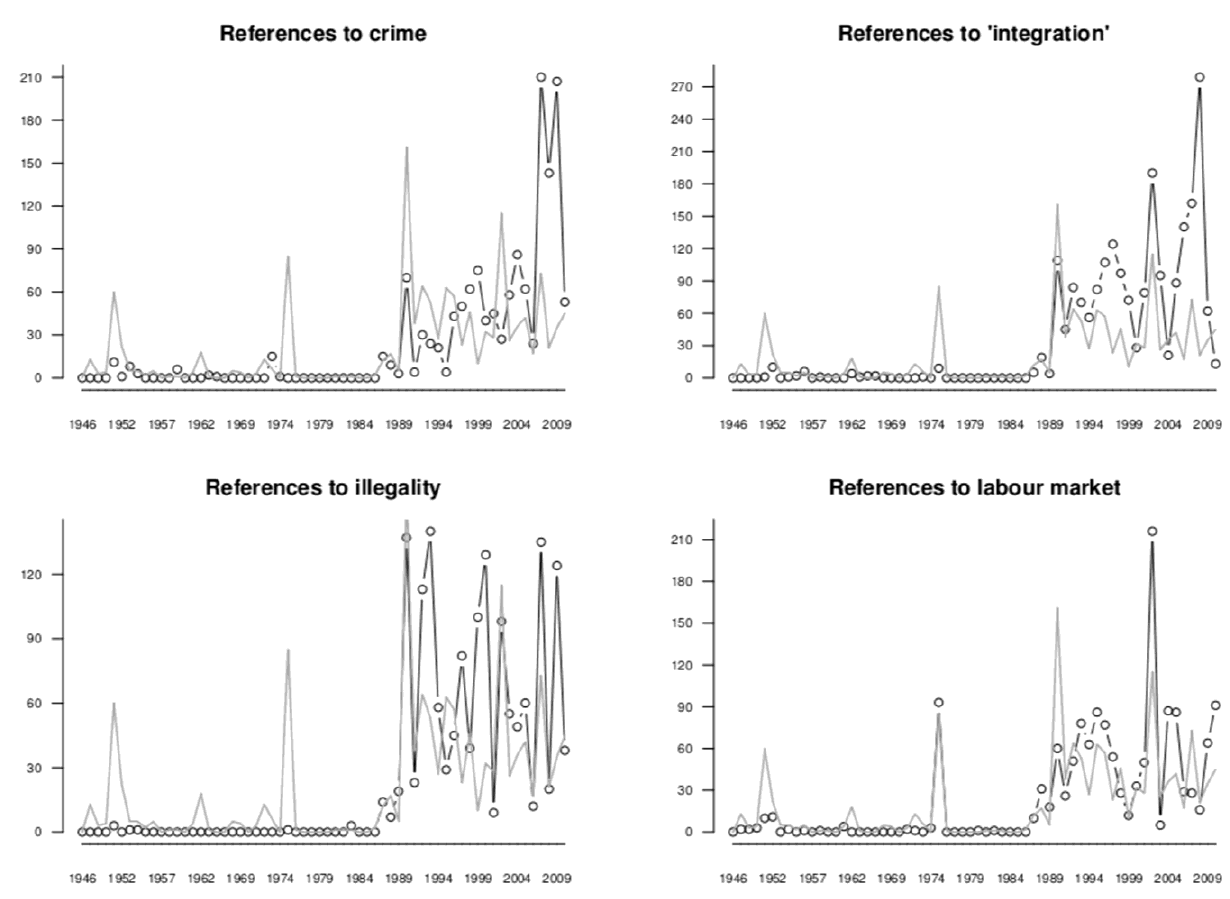
Figure 1. Politicisation and securitisation of migration, 1945–2012; number of references to indicator terms in the Aus- trian parliament; grey line in each graph: references to